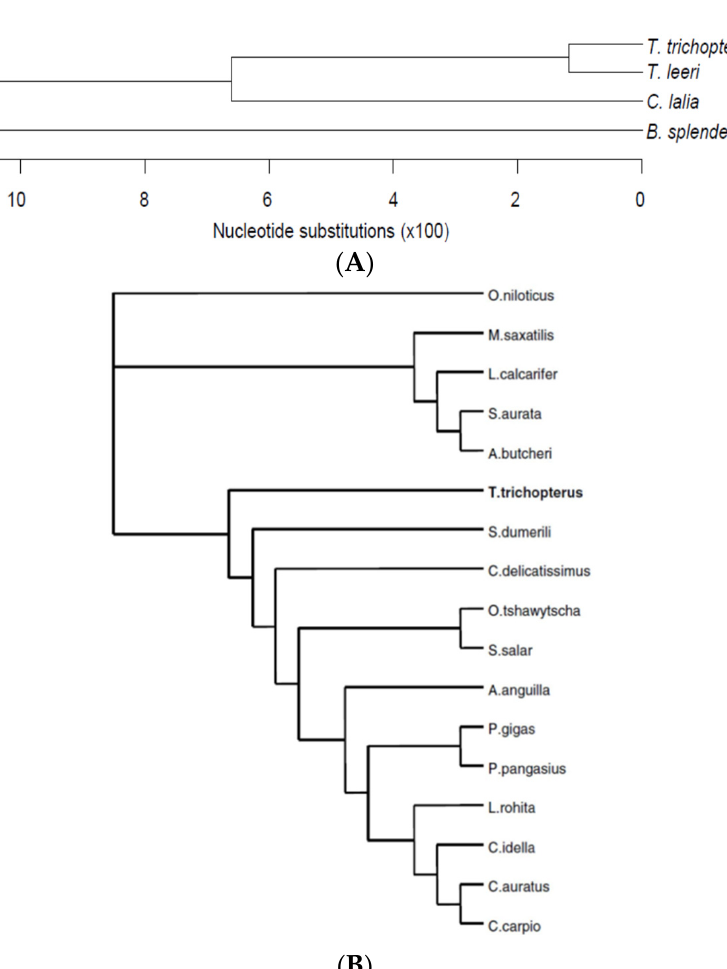
Figure 21. Phylogenetic trees based on the comparison of the deduced amino acid sequence of bgGH to similar Belontiidae family (Anabantoidei suborder) fishes ( A ) and various fish species ( B ) GH found in the GenBank database [41]. Tree was constructed using Neighbor-joining method using Kimura 2 Distance Model, with pairwise deletion and MUSCLE alignment in the MEGA-X software